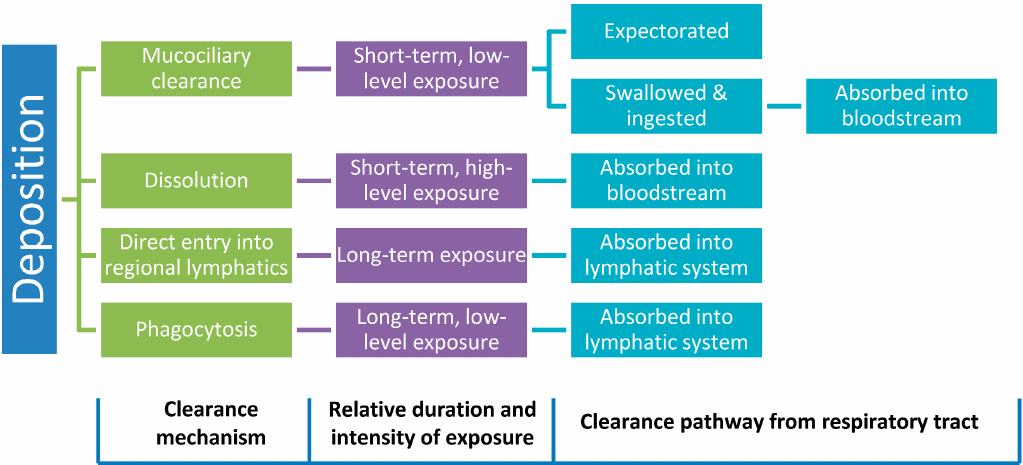
Figure 3. Potential pathways leading to systemic absorption of inhaled arsenic, including clearance mechanisms and their associated durations and intensities of exposure. Adapted from Wang